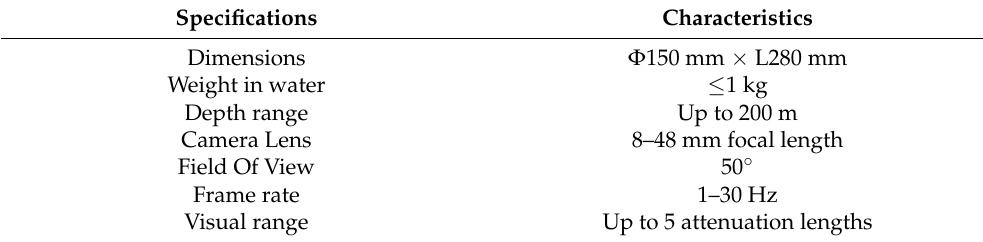
Table 1. Characteristics of the PLRGI